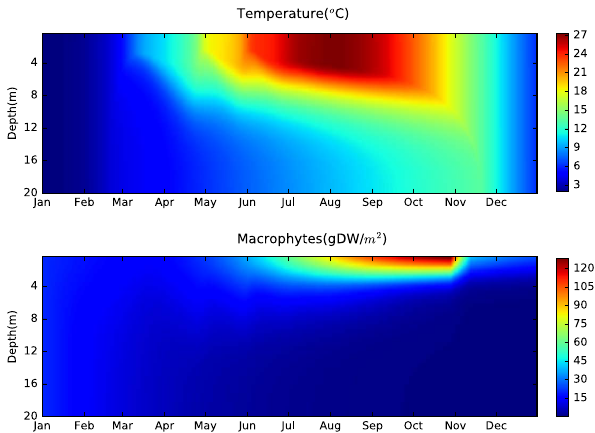
Figure 5. Example of a 1-year simulation of temperature and macrophyte profiles based on FABM-PCLake coupled to the GOTM one-dimensional model (with hypsography enabled, mean- ing that each water column layer interfaces with a certain sediment